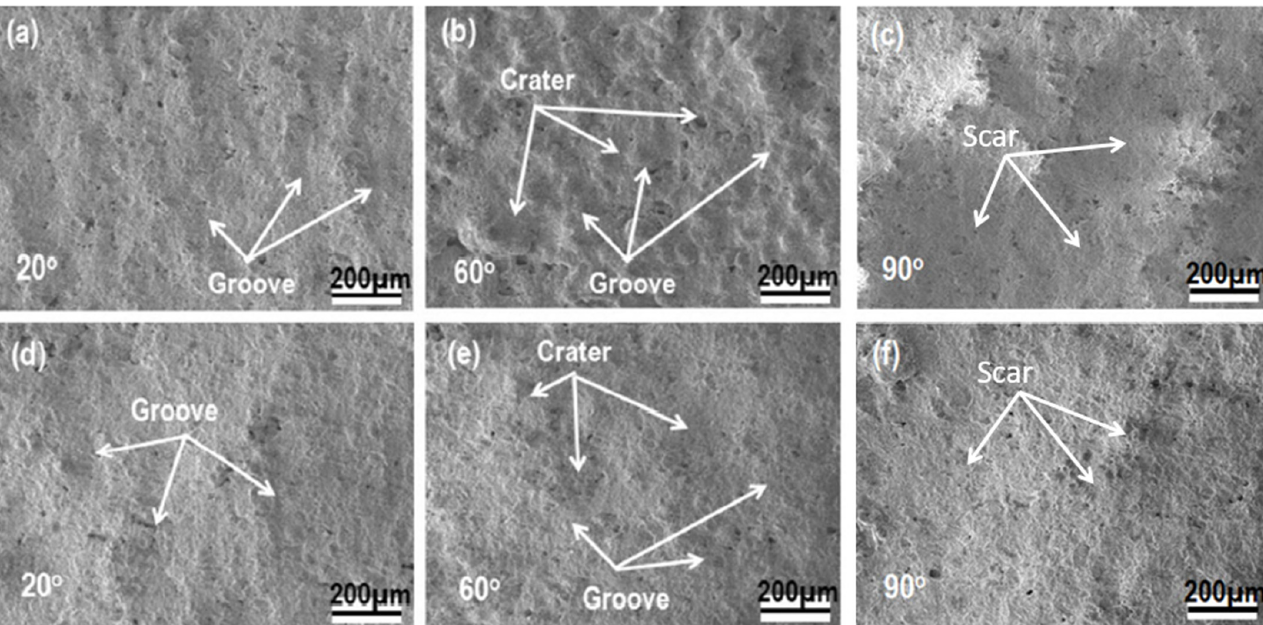
Figure 12. SEM surface morphologies of the TBCs after erosion tests at different impinging angles: ( a – c ) dual-phase zirconia TBC; ( d – f ) Gd 2 Zr 2 O 7 zirconate TBC.